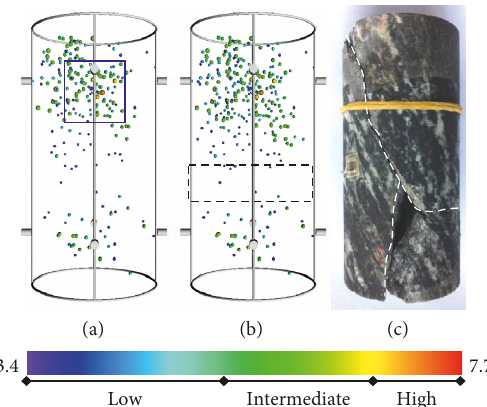
Figure 8: The spatial-temporal distribution of the AE events in Sim9 and the failure mode. (a) 0–351s; (b) 0–364s; (c) the failure